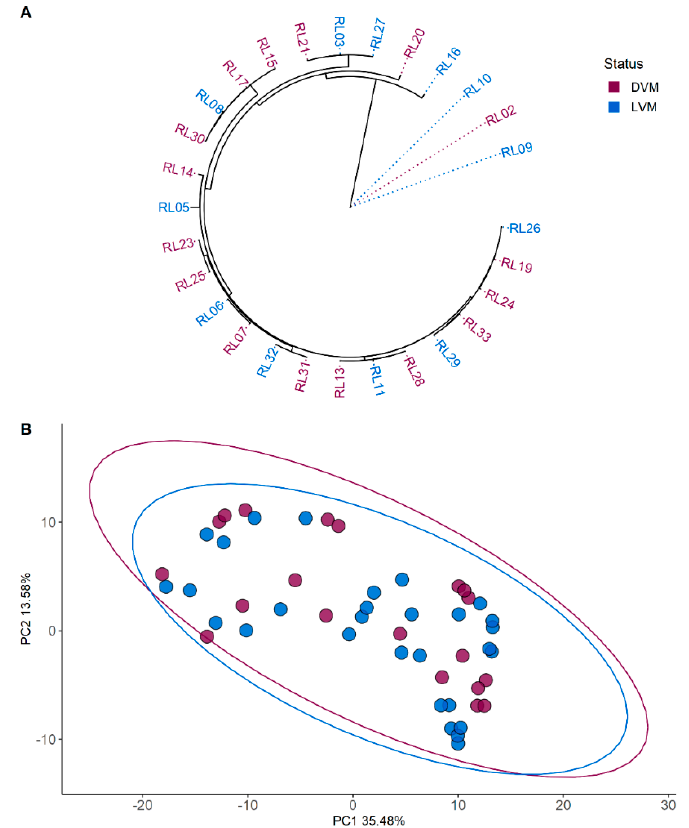
Figure 1. Phylogenetic and metabolomic clustering analyses. ( A ) Core gene phylogenetic tree based on 28 strain sequences. ( B ) Untargeted metabolomics based on 18 strains. Ellipses represent the 95% confidence intervals. Colour coding represents grouping. Burgundy represents strains isolated from dysbiotic vaginal microbiota (DVM) and blue represents strains isolated from Lactobacillus dominated vaginal microbiota